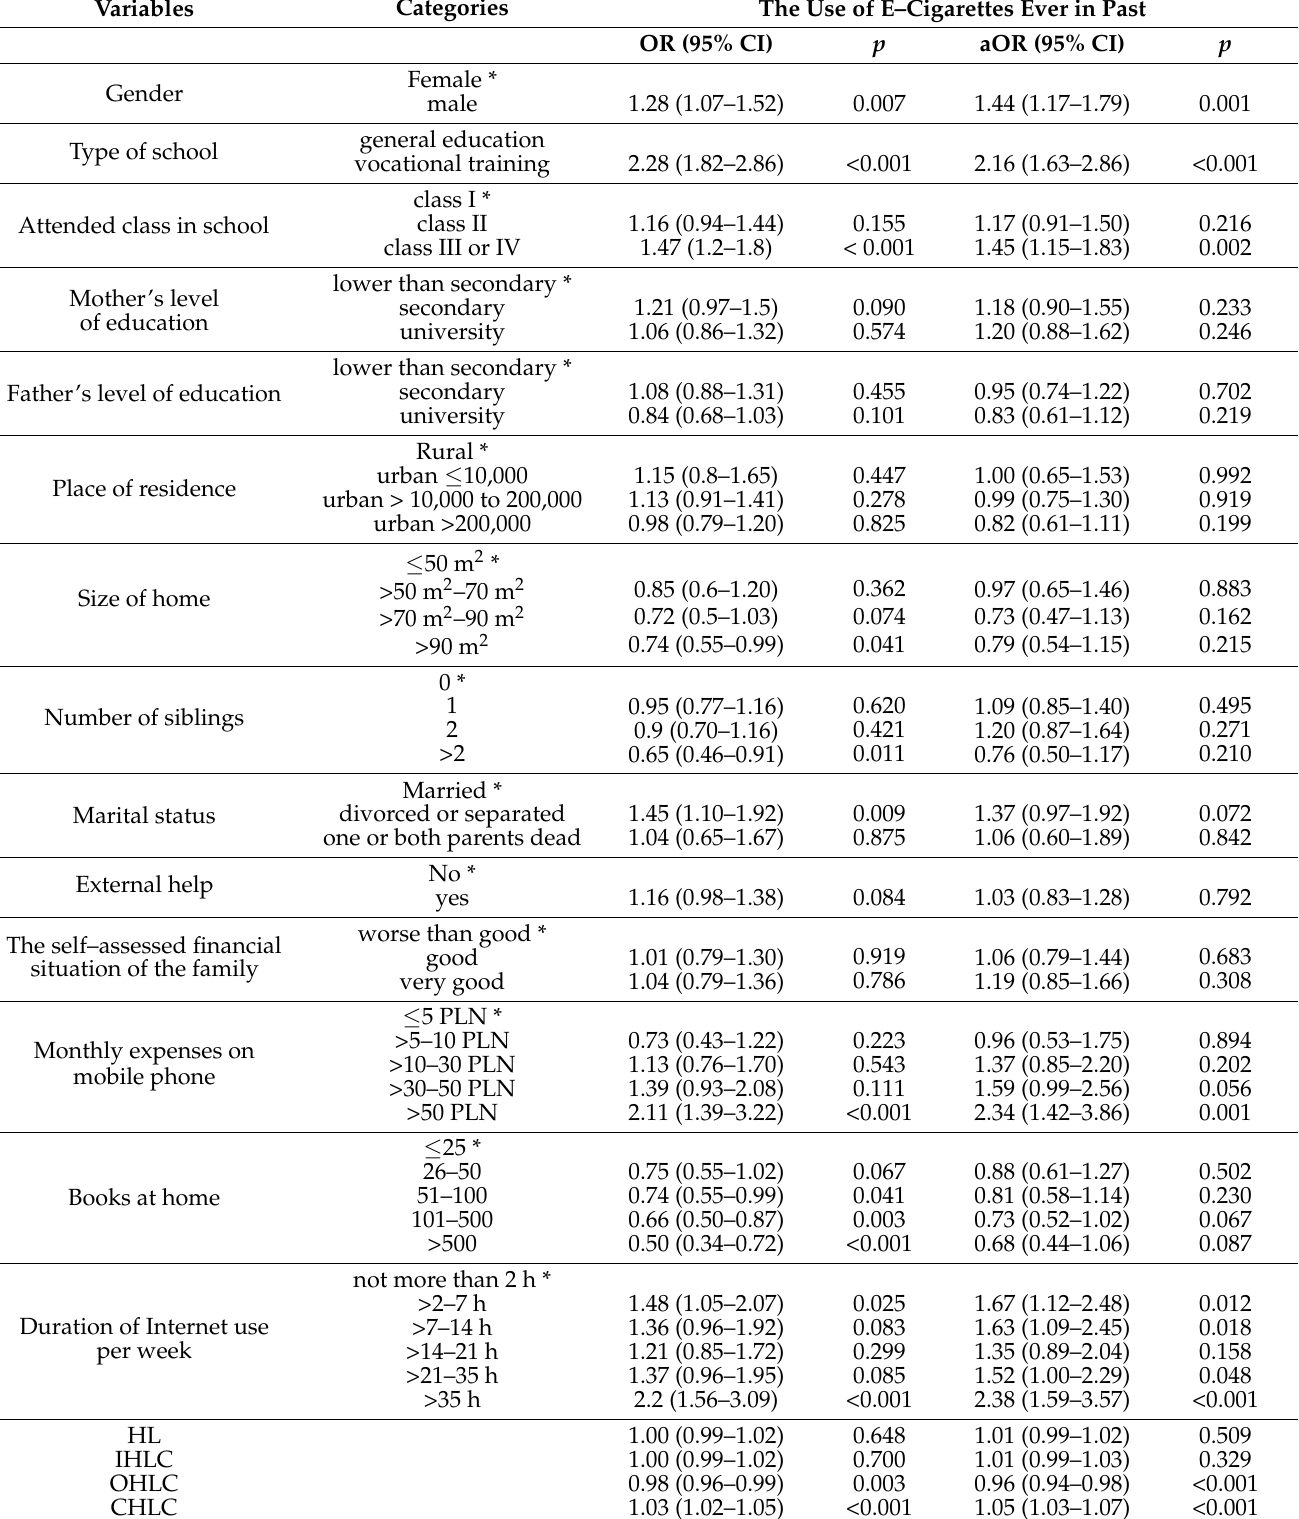
Table 2. Uni- and multivariate logistic regression models for the use of e-cigarettes in the